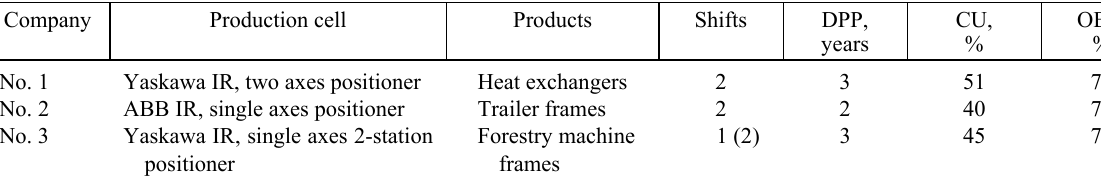
Table 3. Production unit’s description and performances